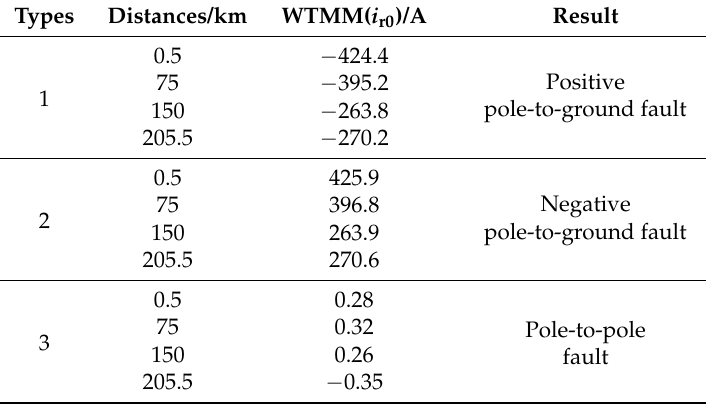
Table 5. WTMMs of 0-mode initial reverse TW current under different fault